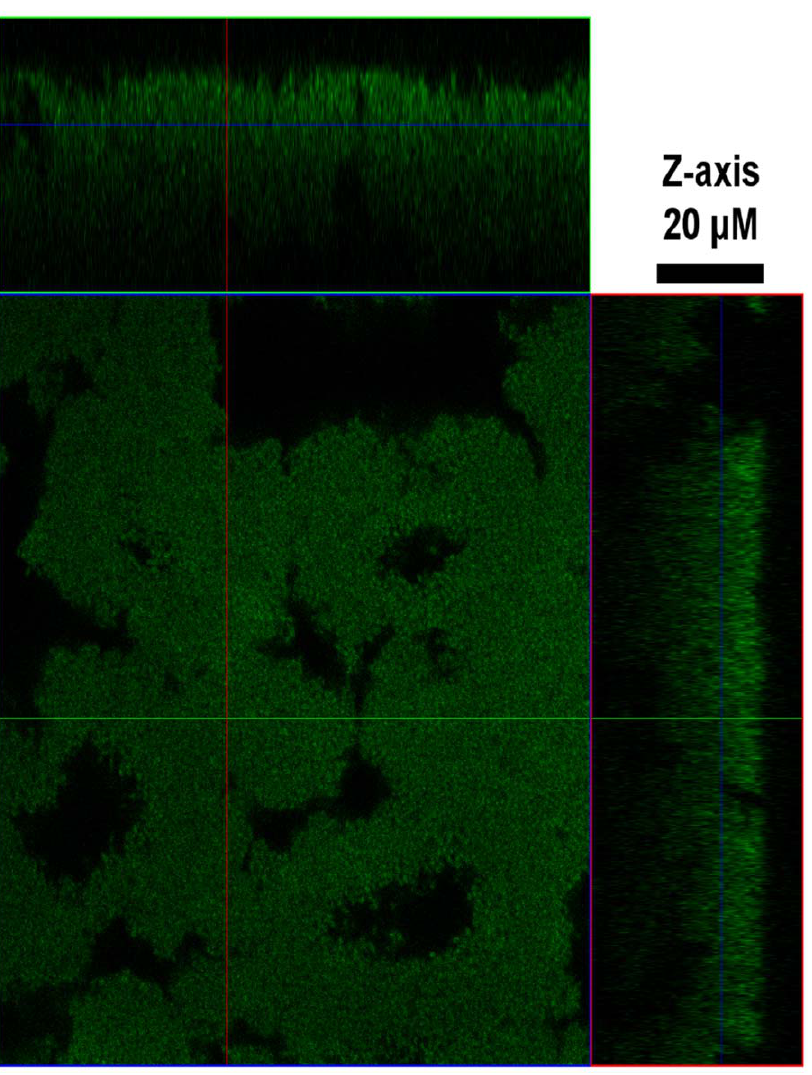
Figure 2. E.coli O104:H4 forms thick biofilms invitro . Confocal laser scanning microscopy revealed the presence of microcolonies (green) following growth of E. coli O104:H4 (TW16133) for 16 hours in a flow cell. Black space represents conduits or channels used for nutrient transport within the biofilm, while the z-axis denotes the thickness.